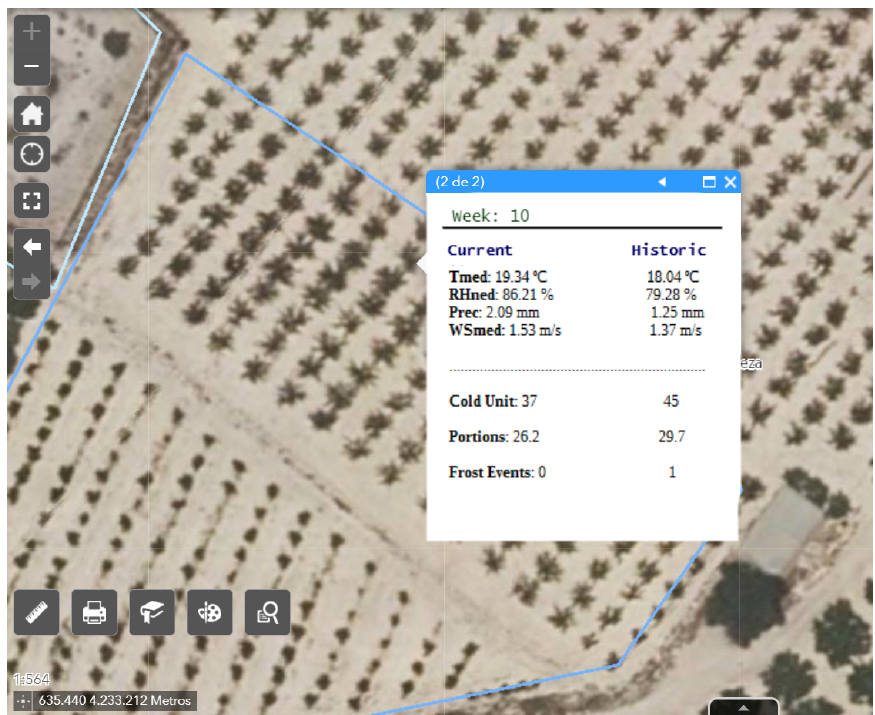
Figure 14. Geographic viewer that shows the evolution of the variables (current and historical) in the